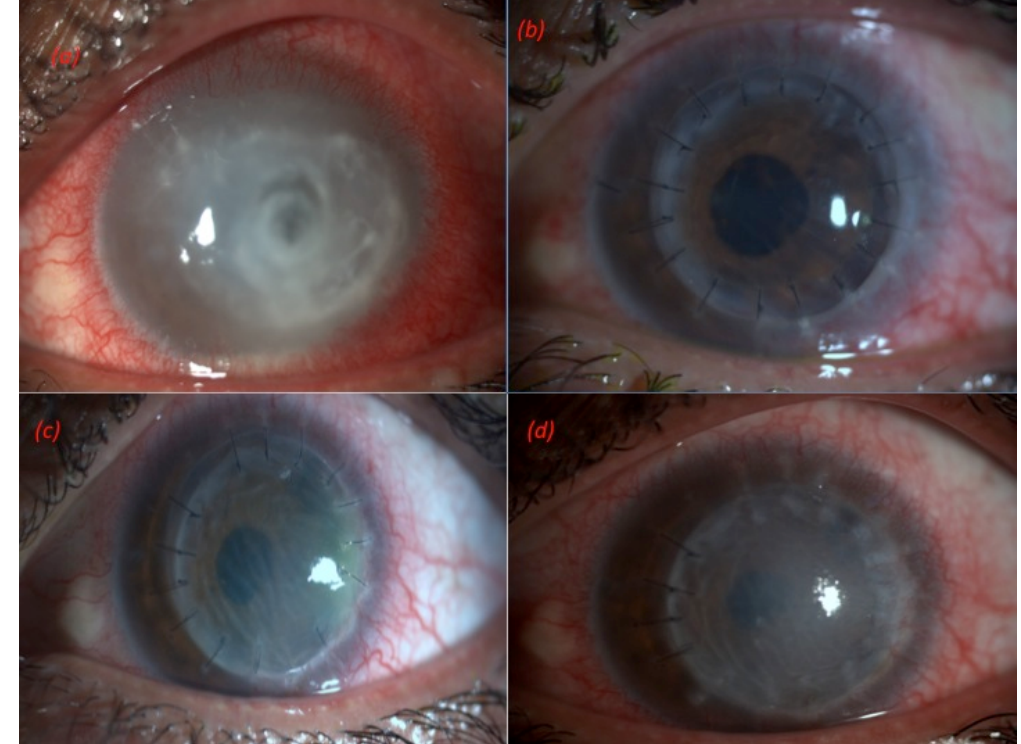
Figure 3: (a) Left eye showing epithelial defect 7 mm x 7 mm, multifocal sub epithelial infiltrates and central 4 mm x 4 mm with a hypopyon of 0.5 mm. (b) Post therapeutic PKP, 8 mm eccentric graft at 1-week follow-up. (c) Fourth month postoperative picture showing stromal edema and signs of graft rejection. (d) Six months postoperative picture showing failed